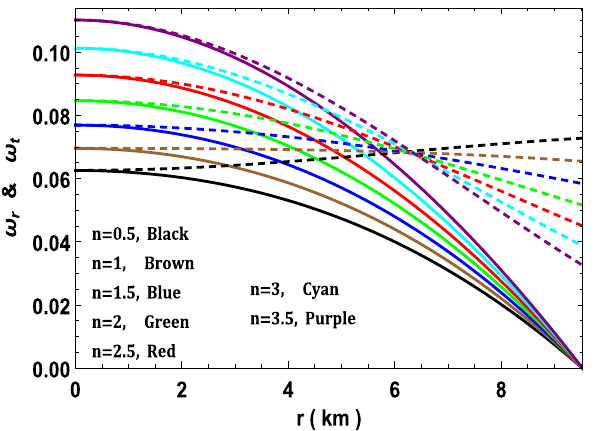
Fig. 5 Variationofpressuretodensityratiowithradialcoordinate r for 4U1608-52( M = 1 . 74 M (cid:9) , R = 9 . 528km)bytaking a = 0 . 001km − 2 and β = 0 . 01